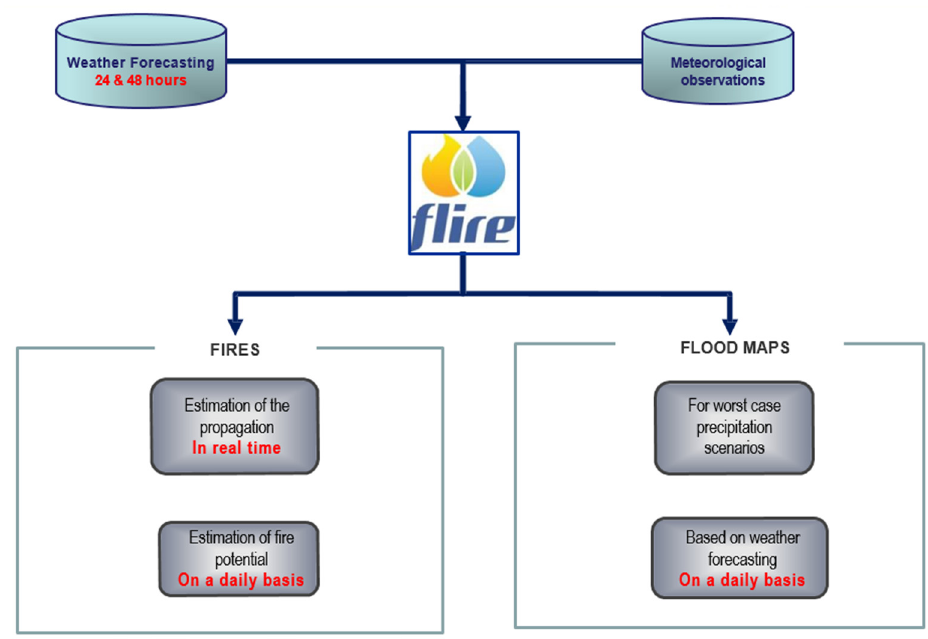
Figure 4. Schematic diagram of the web-based platform for combined flood and fire forecasting and warning [43].